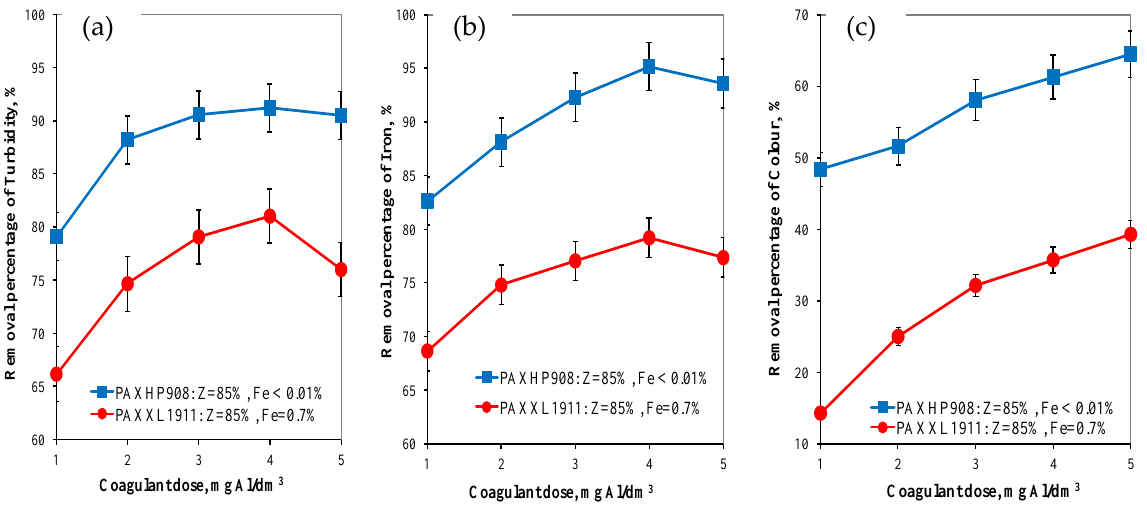
Figure 2. The effect of the type and dose of a coagulant on the efficiency of removing turbidity ( a ), iron ( b ) and colour ( c ).